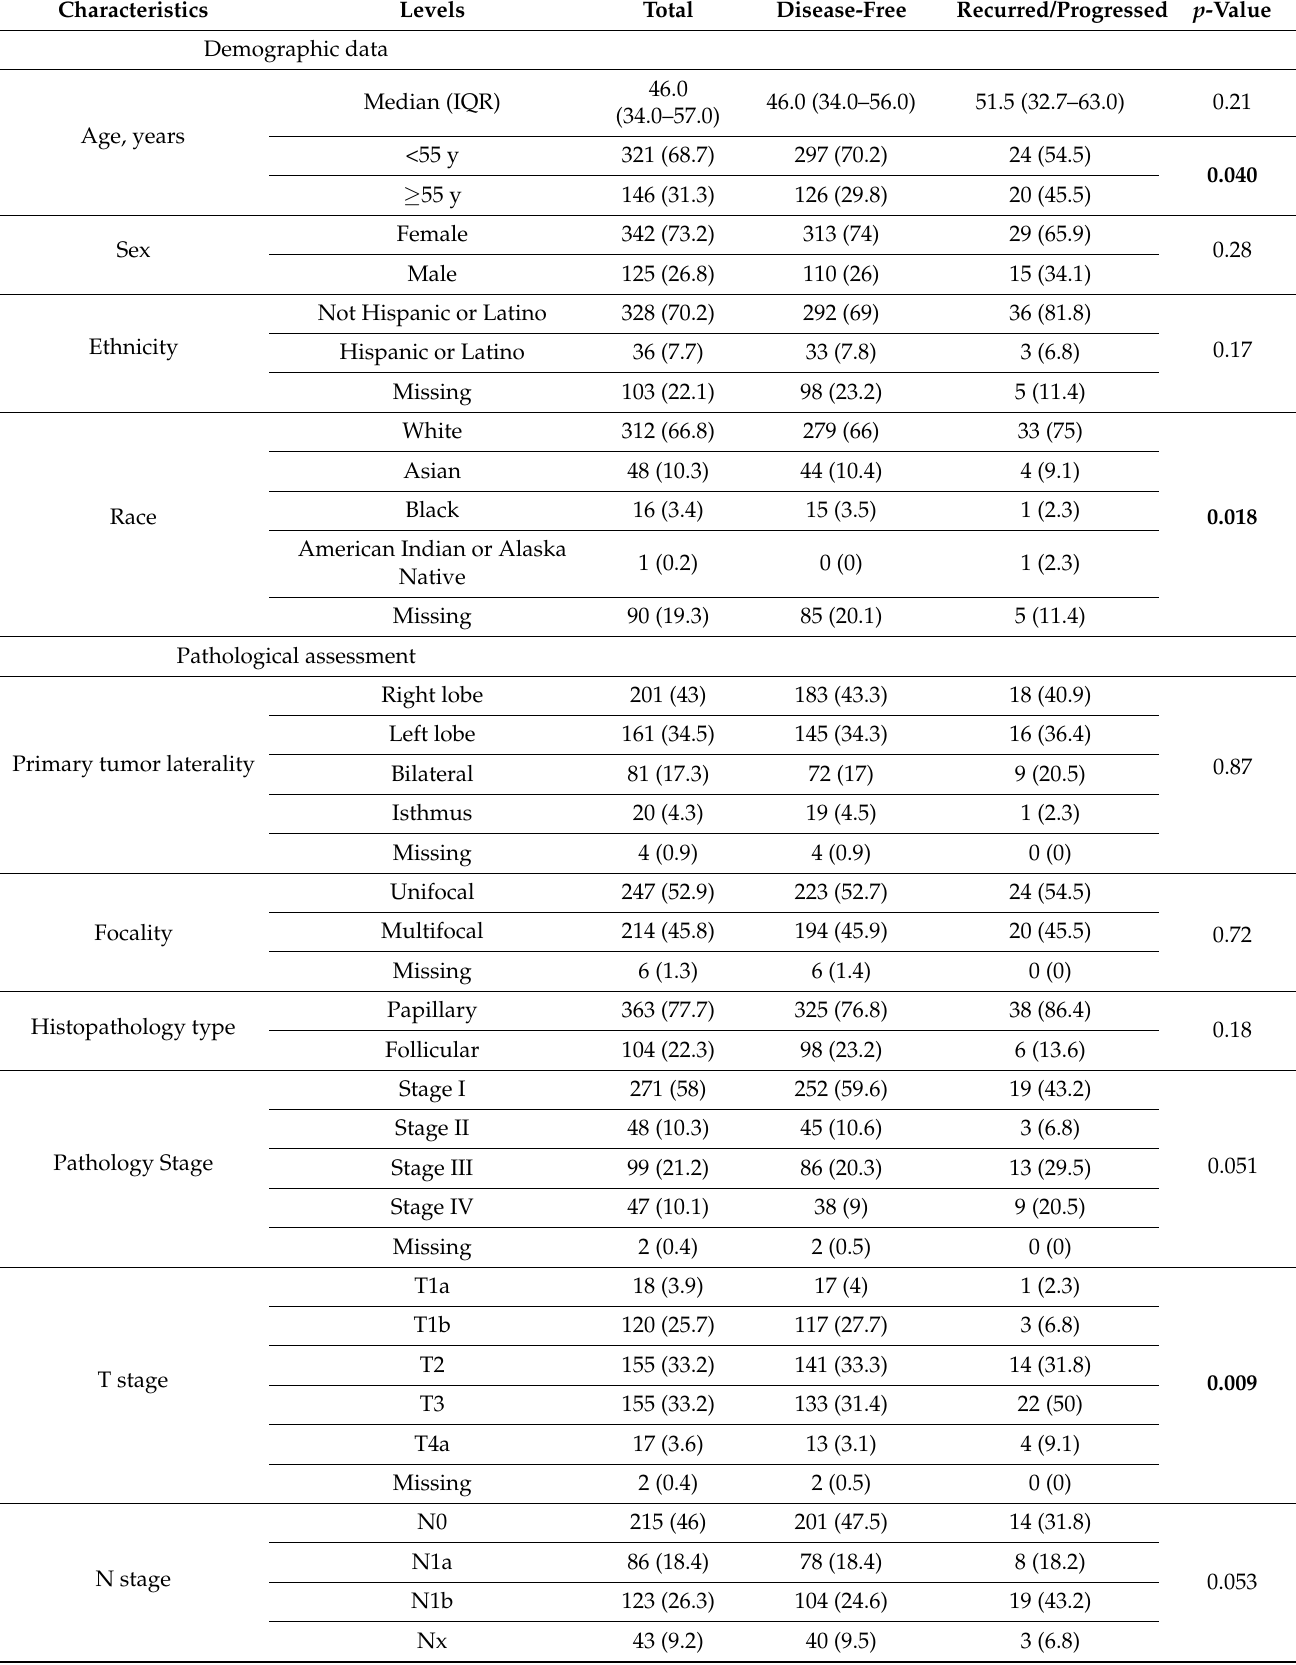
Table 1. Characteristics of the study population ( n =